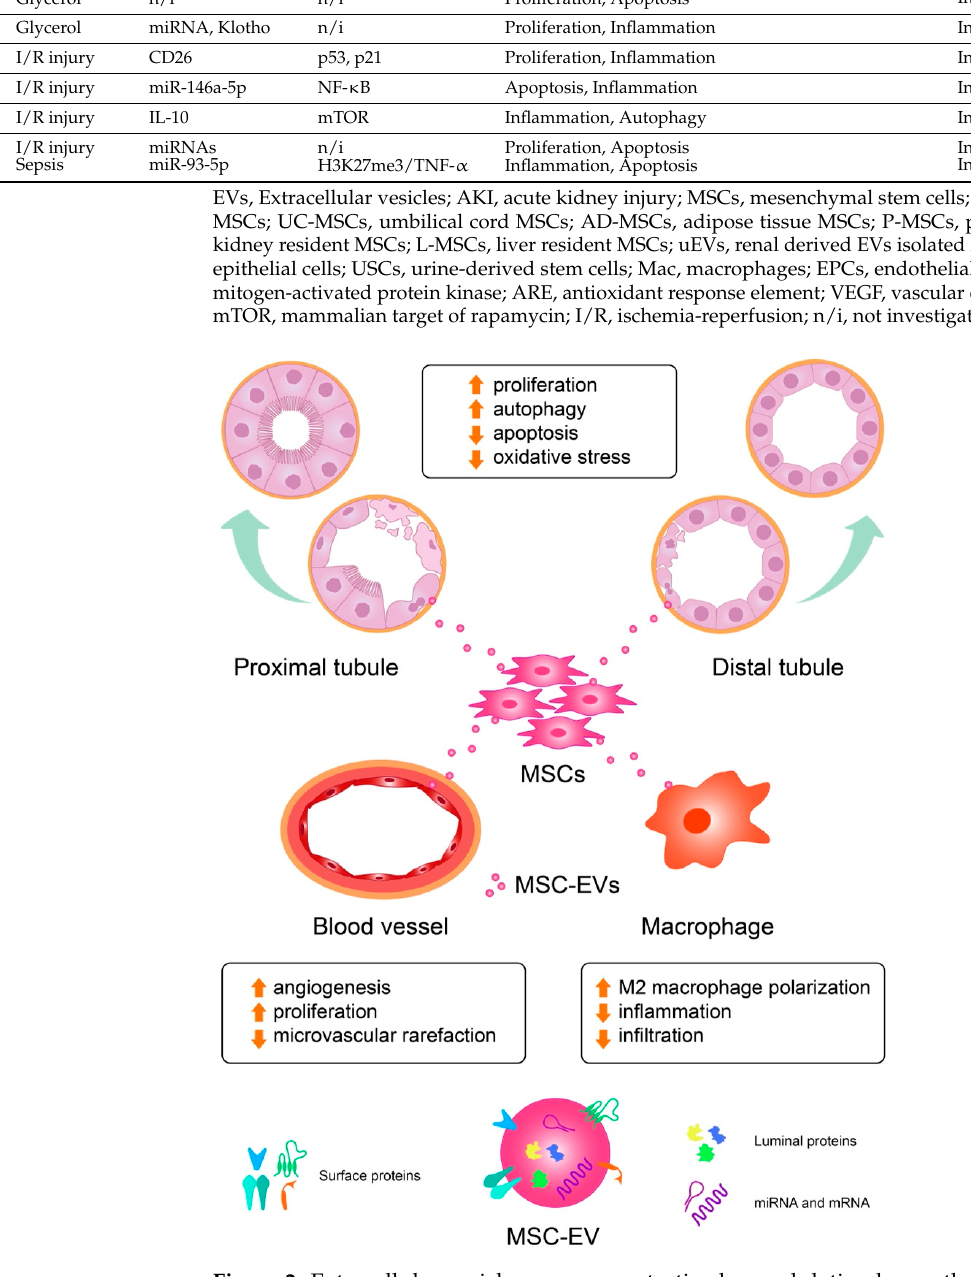
Figure 2. Extracellular vesicles are renoprotective by modulating key pathways implicated in the pathophysiology of kidney injury. Administration of MSC-derived EVs protects from kidney